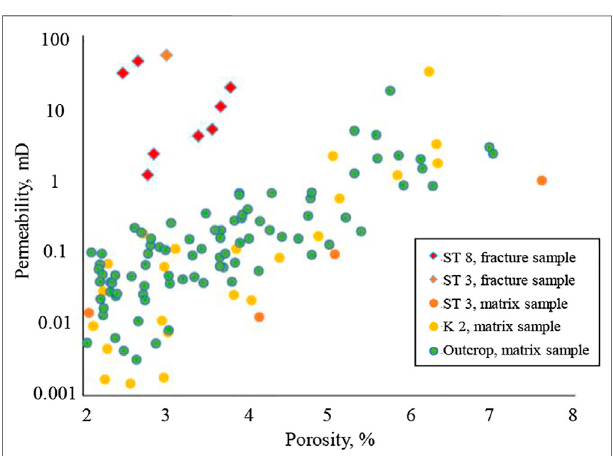
FIGURE 2 | Correlation diagram between porosity and permeability, Qixia Fm, Sichuan Basin, China.